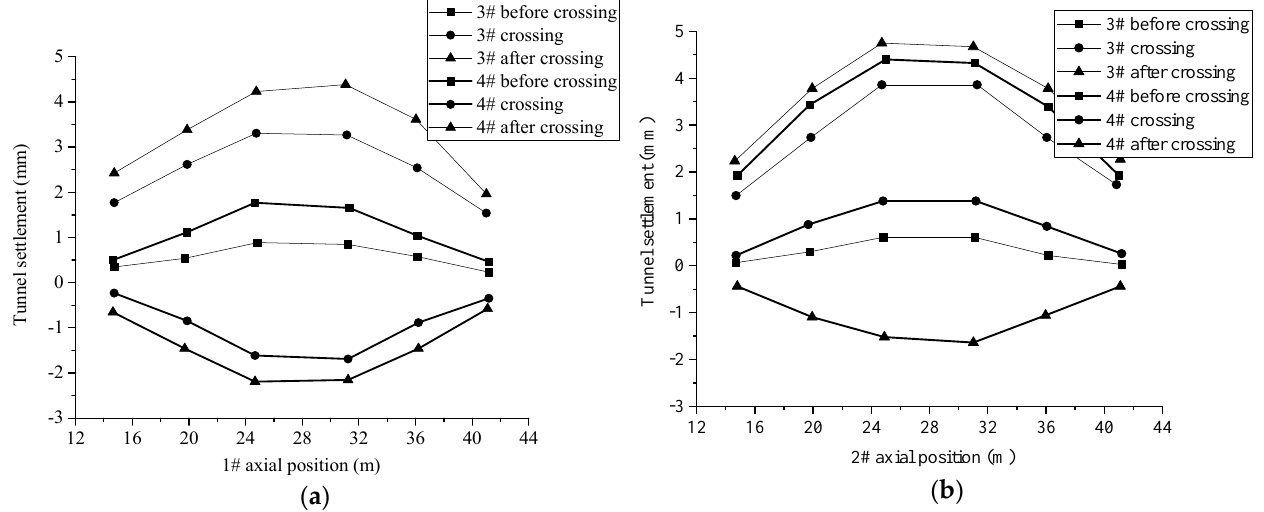
Figure 13. The longitudinal displacement of the existing tunnels, ( a ) No. 1 and ( b ) No. 2, under the condition of first-up and then-down